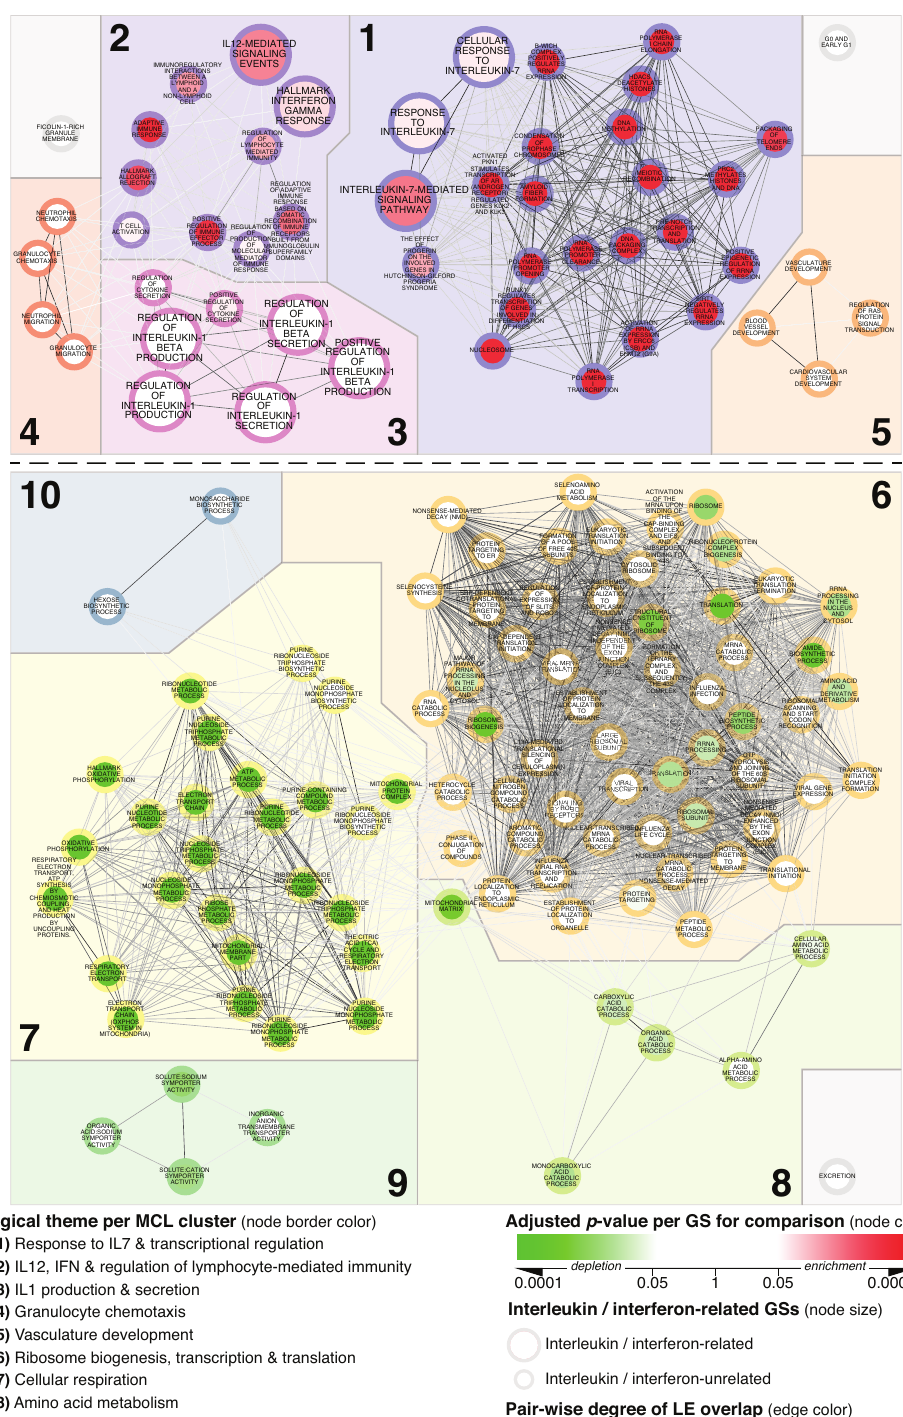
Figure 2. MCD’s glomerular transcriptional landscape delineating contextualized alterations in gene expression between MCD and MN. Any GS passing the significance thresholds of adjusted p < 0.001 and with at least 33.34% of its member genes comprised in its leading edge (LE) when comparing MCD vs. N_CTRL was mapped as a node within the basic network. Onto this scaffold, the parameters listed in the legend for the comparison of MCD vs. MN were mapped. By keeping all mapping parameters constant, this figure is directly comparable with Figures 1 and